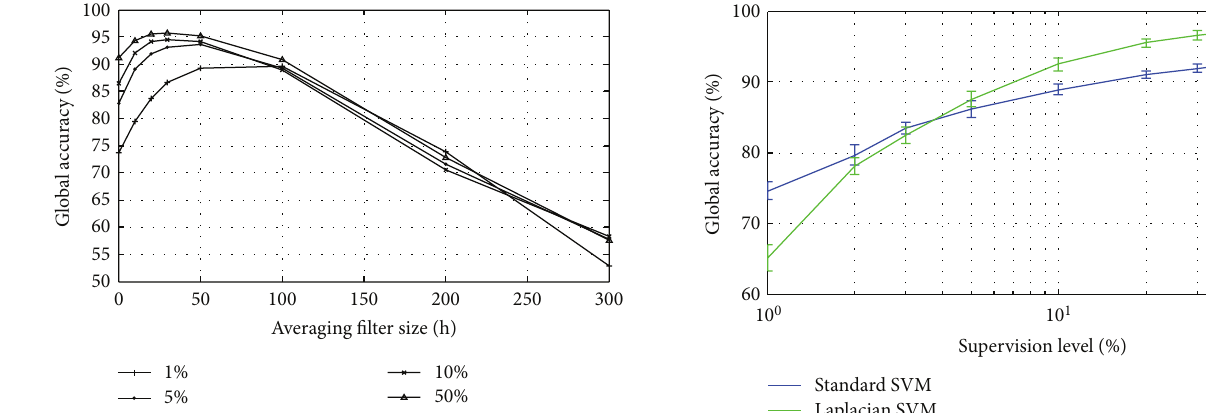
Figure 8: Comparison of standard single feature SVM with semi- supervised Laplacian SVM with RBF kernel on SPH Level 3 visual features (IDOL2 dataset, random